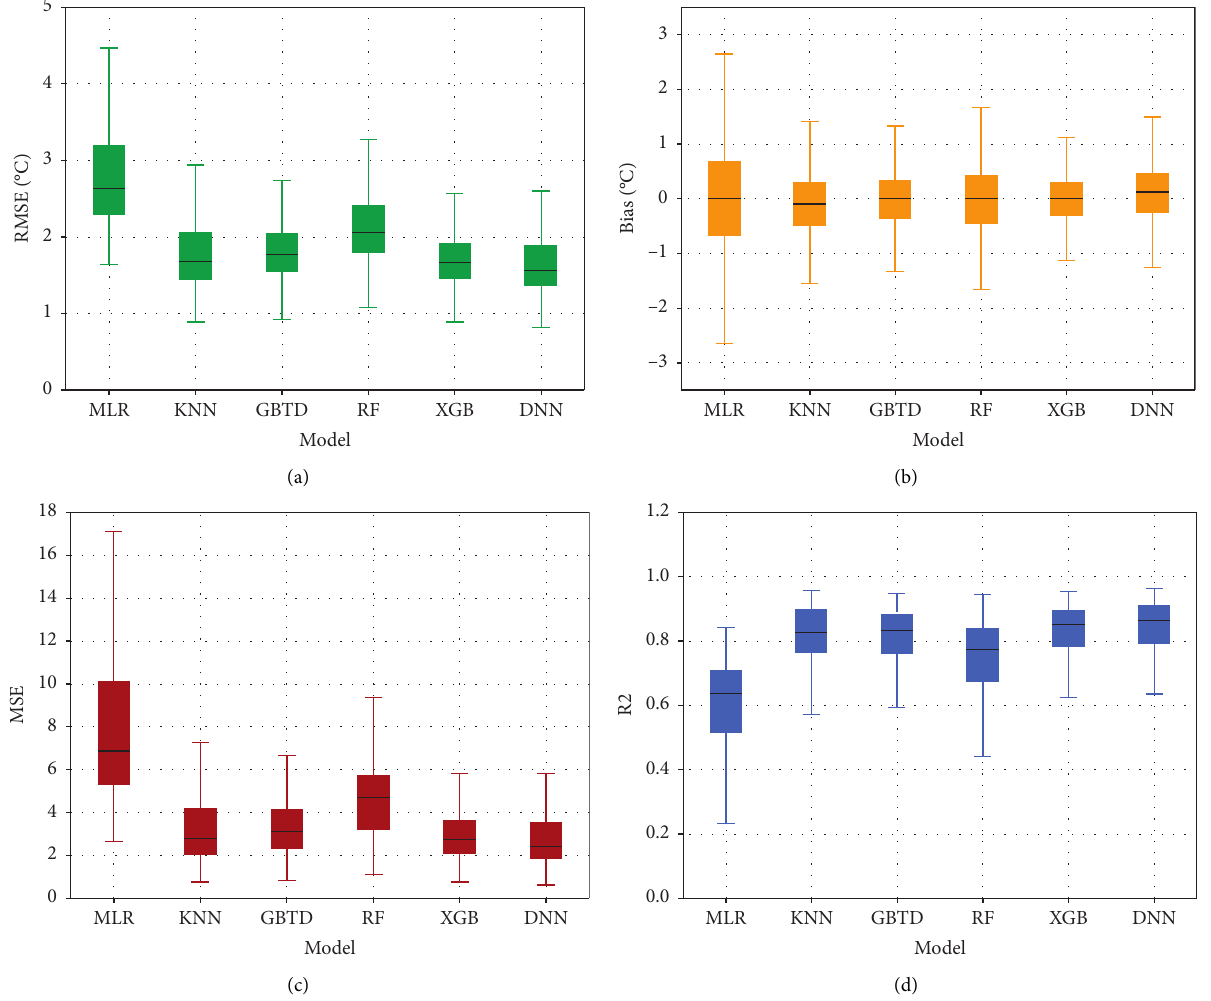
Figure 5: Boxplots of performance evaluation for the six models (MLR, KNN, SVM, RF, XGB, and DNN) using the test dataset in terms of (a) RMSE, (b) Bias, (c) MSE, and (d) R 2